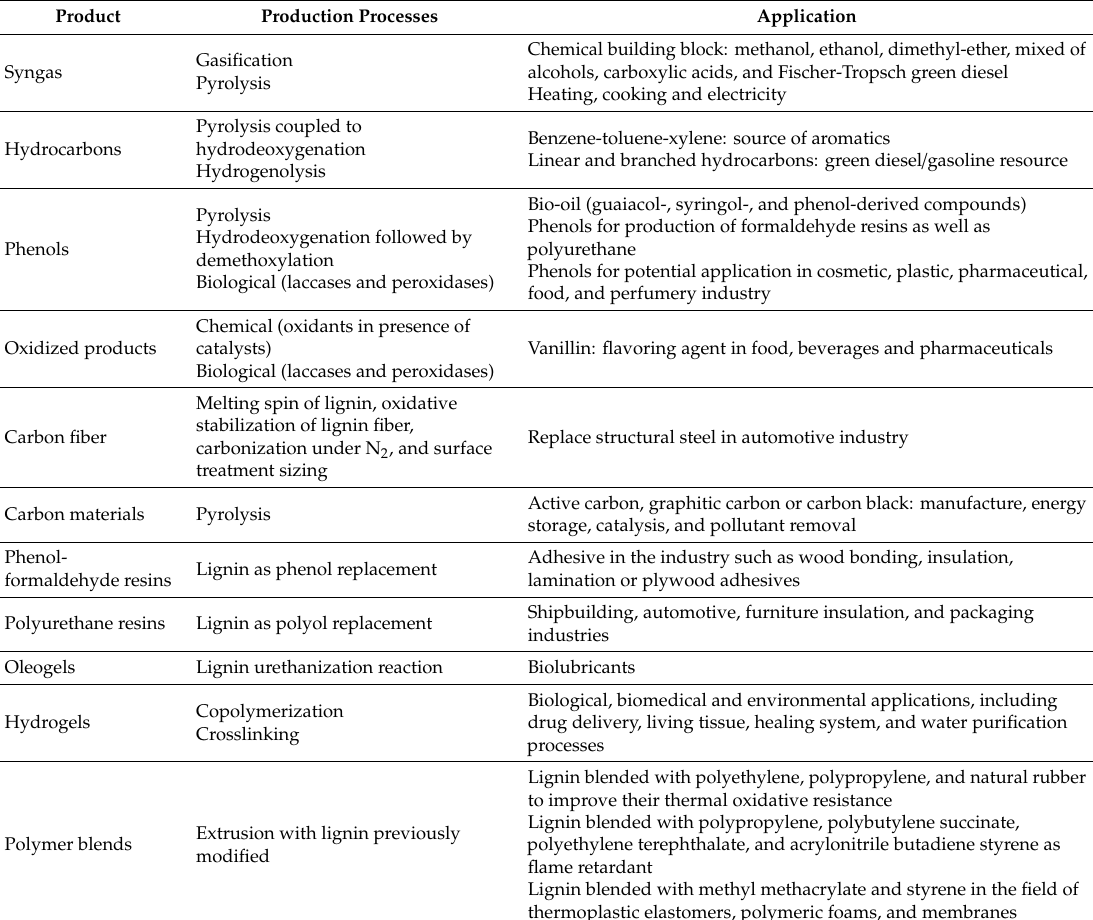
Table 3. List of bio-based products from the lignin